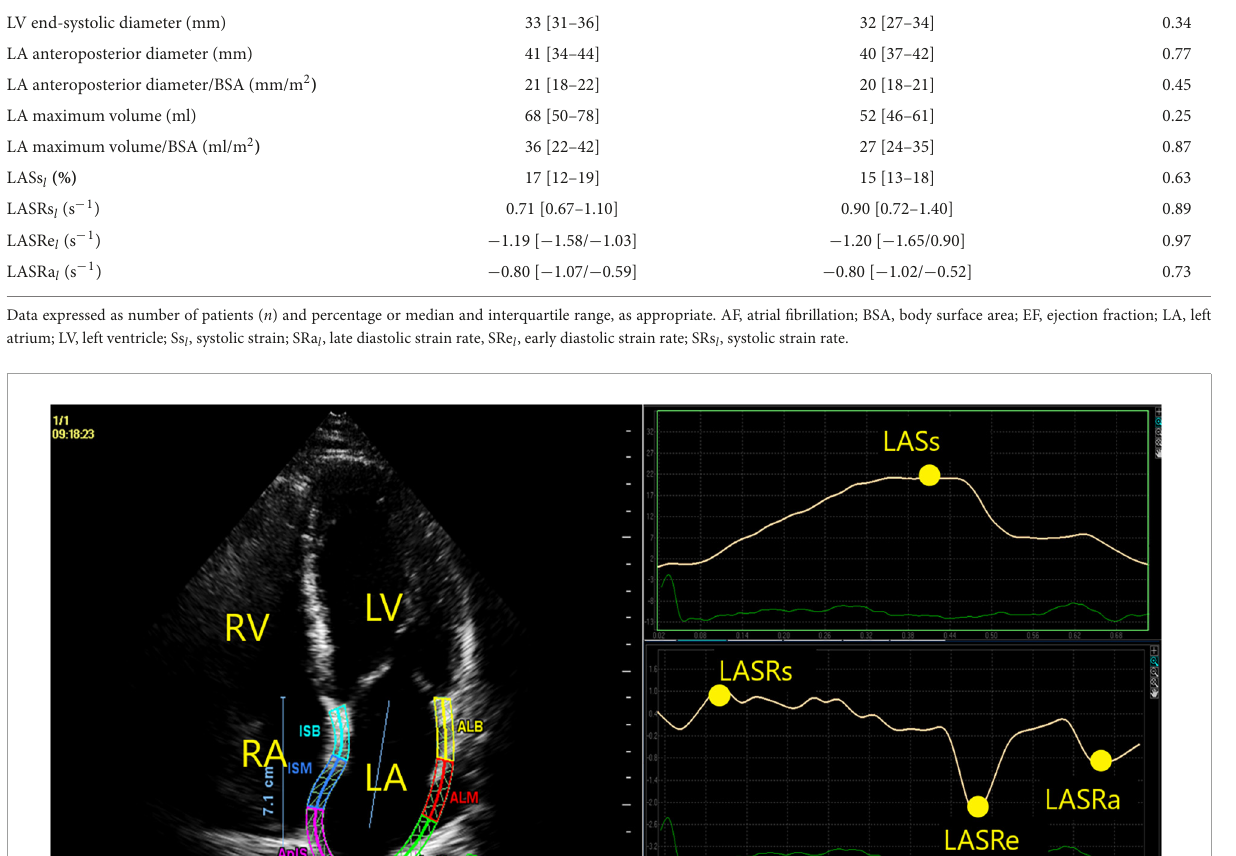
ipsilateral were delivered as previously described (5,